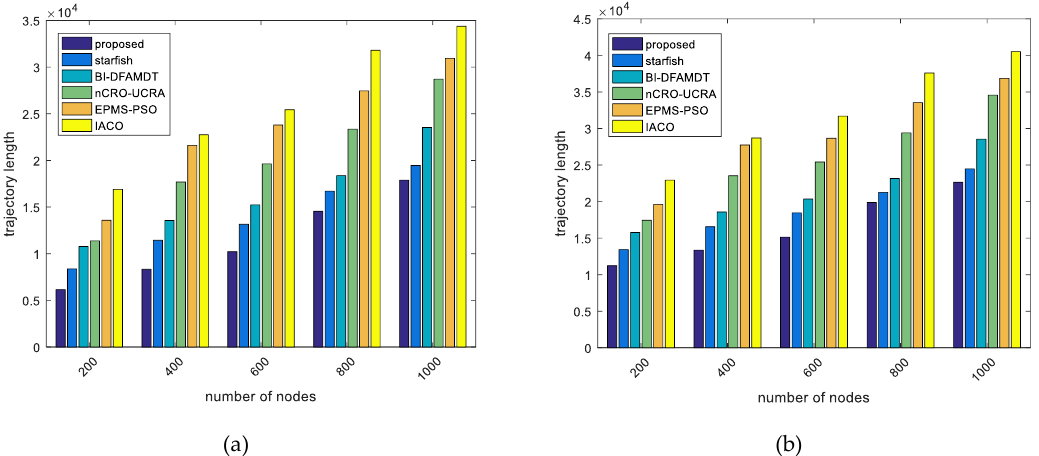
Figure 14. Comparison of the proposed scheme with existing algorithms versus trajectory length travelled by MS: ( a ) Simulation graph for scenario 1; and, ( b ) Simulation graph for scenario 2.